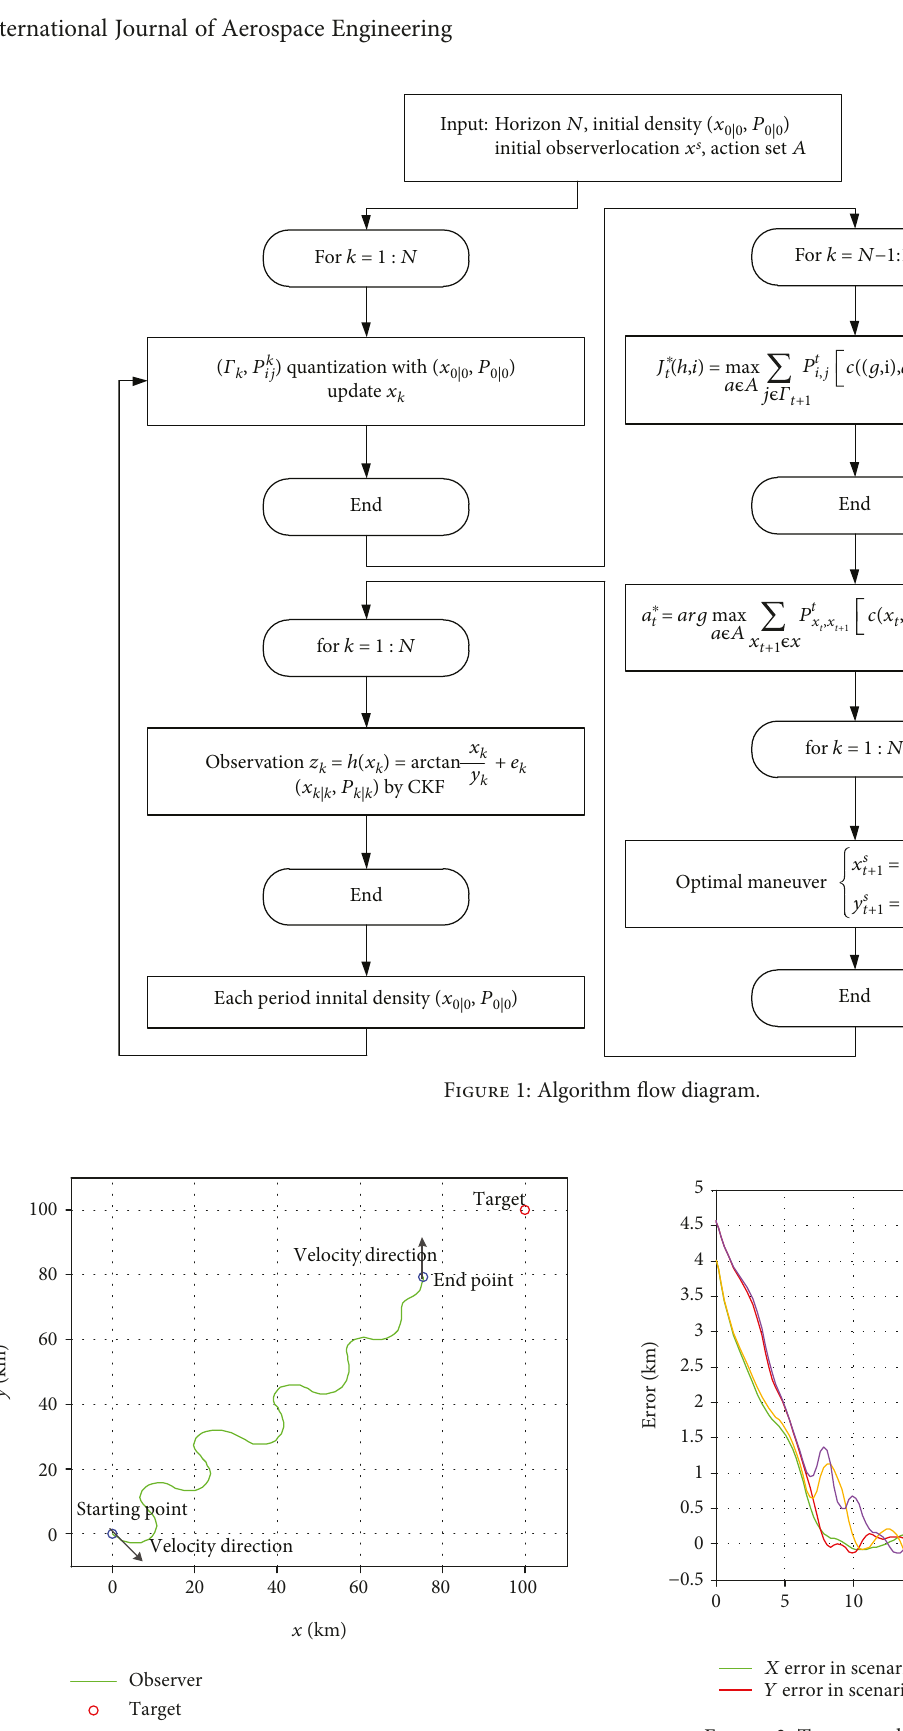
Figure 2: Static target tracking in scenario 1.